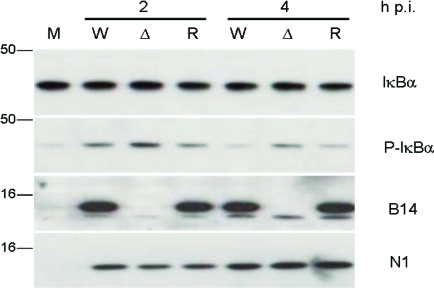
B14 Reduces the Phosphorylation of IκBα in VACV-Infected CellsCytoplasmic extracts were prepared from HeLa cells at the indicated times after mock-infection (M) or infection with vB14 (W), vΔB14(Δ), and vB14-rev (R) at 2 p.f.u. per cell. Cytosolic proteins (15 μg per lane) were resolved by SDS-PAGE (15% gel) and analysed by immunoblotting with the Abs indicated on the right. Sizes of bands detected are indicated on the left in kDa.